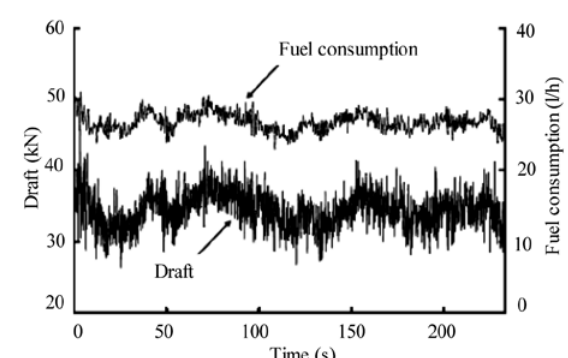
Fig. 1. Dependencies of traction force and fuel consumption and their interrelation in real-time soil preparation work (Li et al .